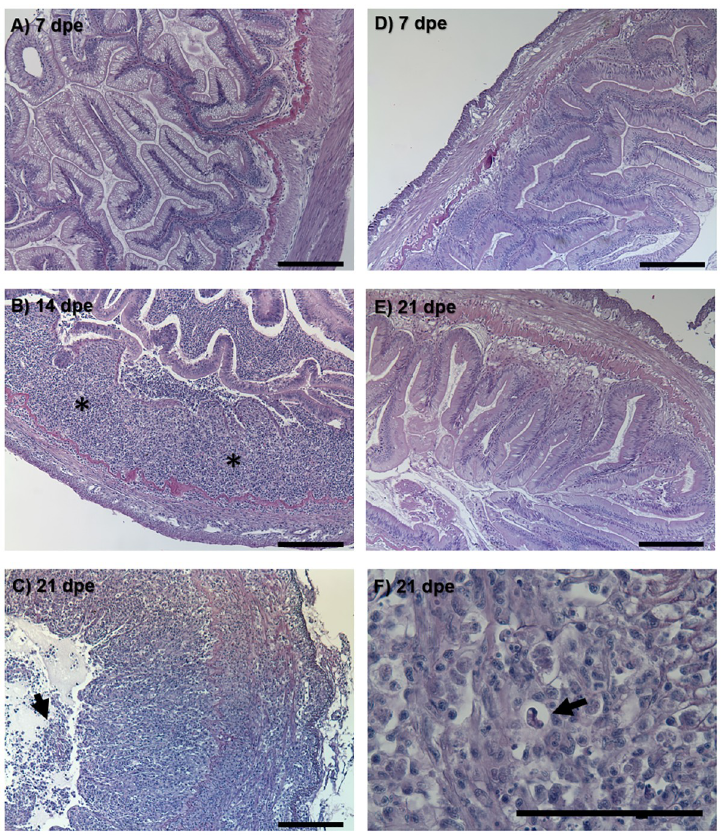
Fig 2. Histological sections of resistant and susceptible steelhead intestine after exposure to Ceratonova shasta . Susceptible fish intestine at (A) 7 days post exposure (dpe), (B) 14 dpe showing chronic inflammation (asterisks) throughout the submucosa, and (C) 21 dpe with inflammation present in all tissue layers and sloughing of necrotic epithelia (arrow). Resistant fish intestine at (D) 7 dpe and (E) 21 dpe. Mature C . shasta myxospore (arrow) in the intestine of susceptible fish at 21 dpe (F). Bars = 100 μ